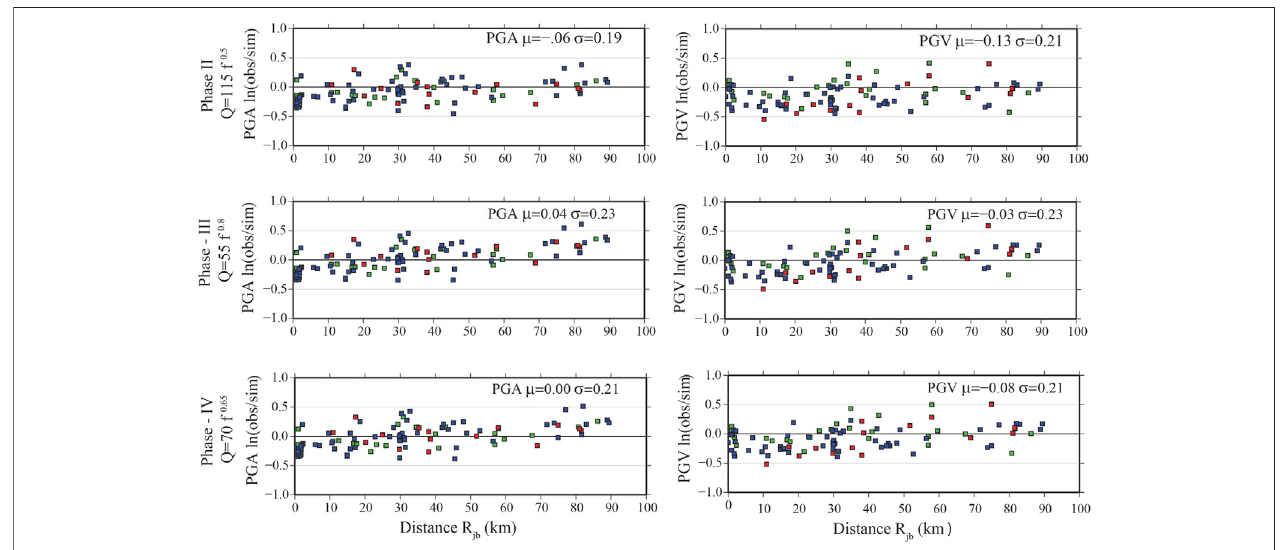
FIGURE7| Residualsbetweengroundmotionparameters observedondatarecordingsandsimulatedtime-seriesfortheM6.3Norciaearthquakeasafunctionof distance for three attenuation functions: peak ground acceleration (PGA) and peak ground velocity (PGV).